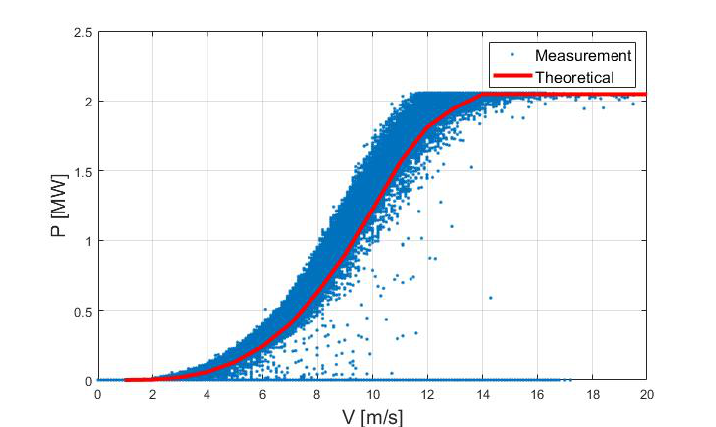
Figure 3. The actual as-measured data (in blue) and theoretical data (in red) of wind turbine E70 power characteristics, wind power plant FW3 [46].